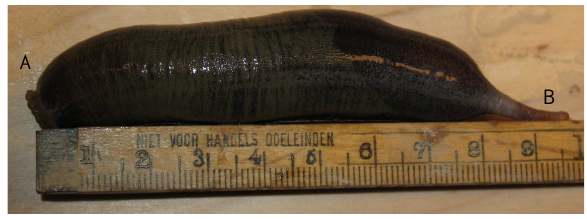
Fig. 2. A picture of a specimen of Molpadia musculus immedi- ately after collection, when analysed for biometric variables. (A) – mouth, (B) –